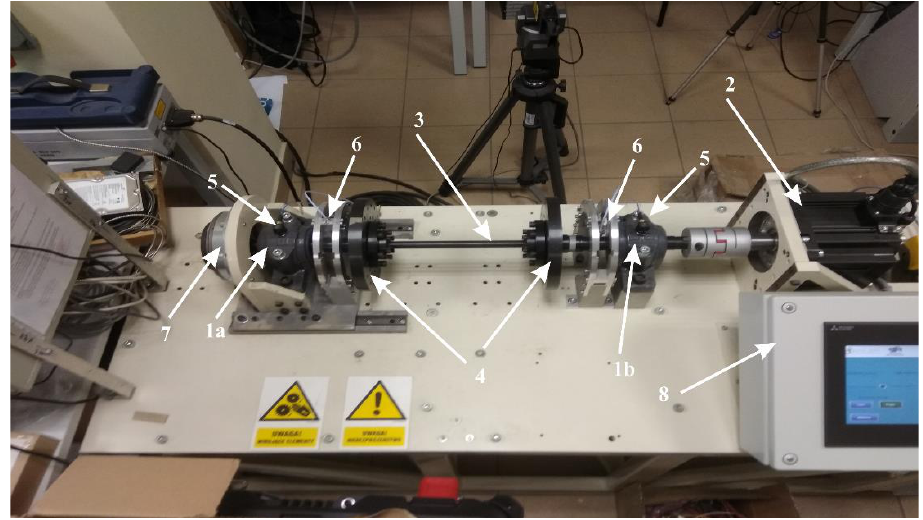
Table 1. Legend for the damage maps.